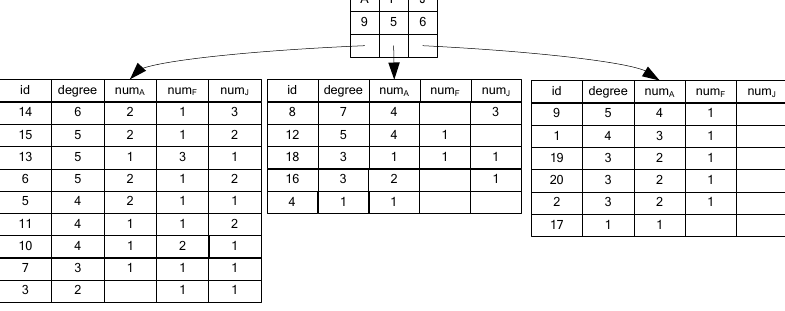
Figure 3. Node topology feature (NTF) index for G in Figure 1.